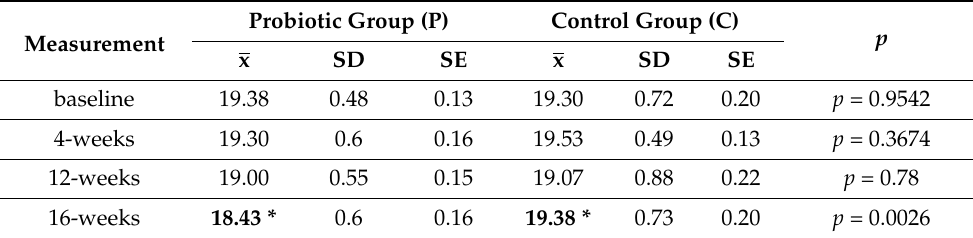
Table 3. The subjective feeling of fatigue according to the Borg scale during the aerobic